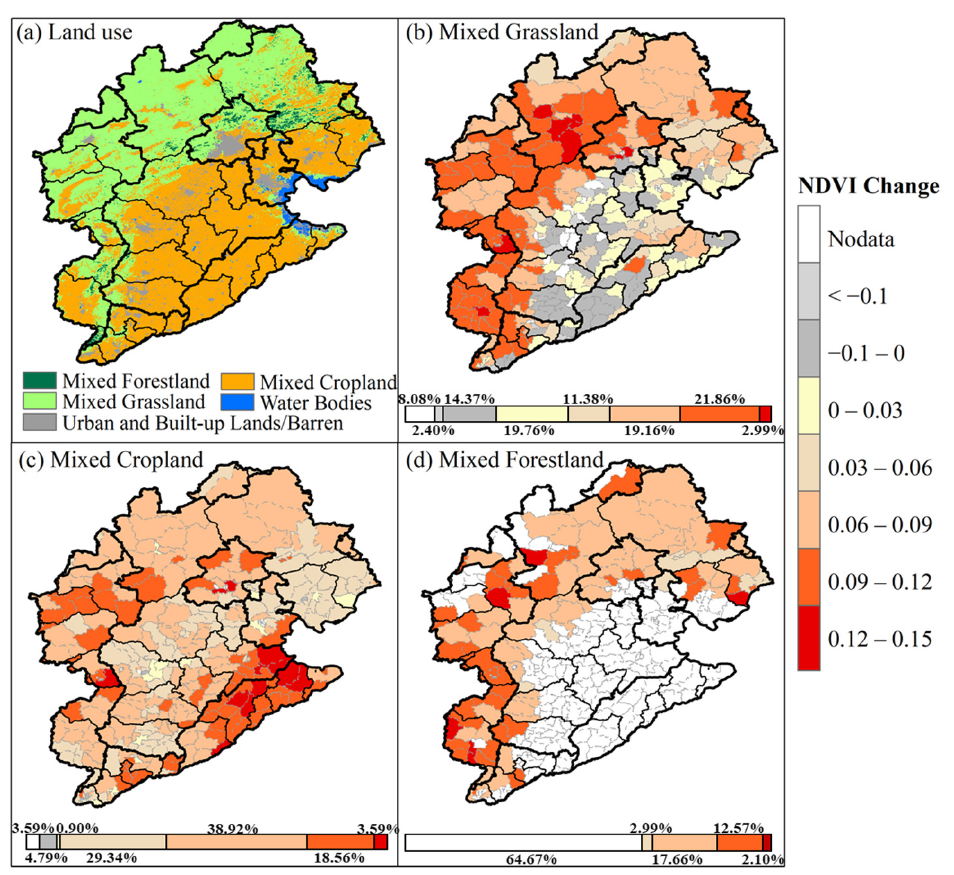
Figure 3. ( a ) Land cover categorization map of the study area in 2002; ( b ), ( c ), and ( d ) depict the difference in normalized difference vegetation index (NDVI) between 2018 and 2002 for mixed grassland, cropland, and forestland, respectively. The horizontal bar in each panel shows the frequency of each change level. Nodata means there is no corresponding vegetation type in this county.